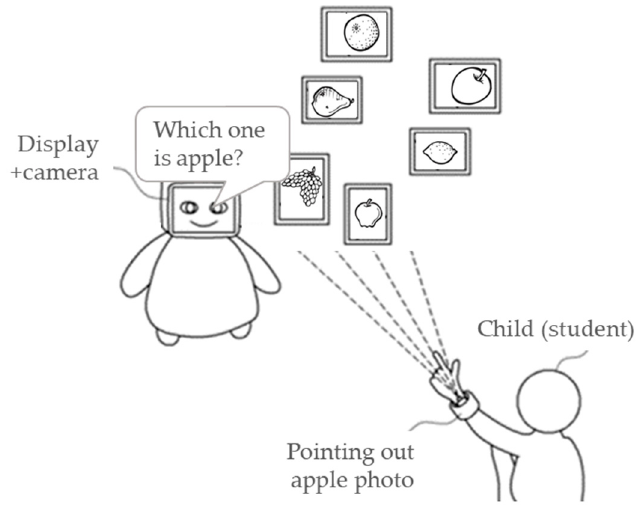
Figure 11. Example: Robot-child interaction of fruit quiz.